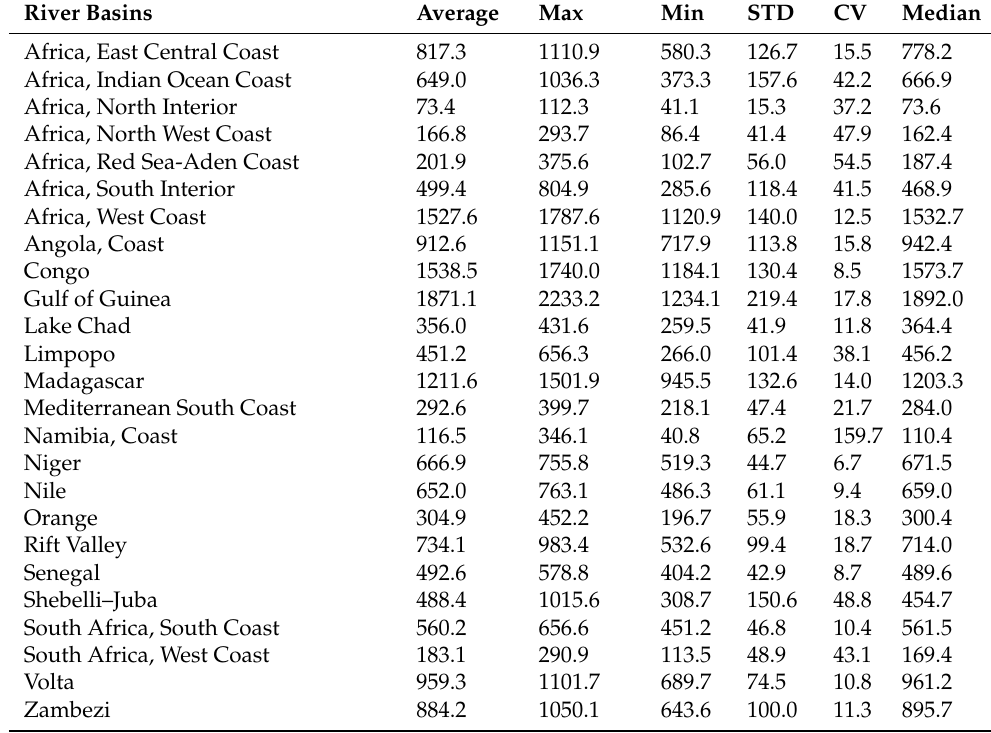
Table 2. Descriptive statistics for Africa’s annual rainfall (in mm) for major river basins from TAMSAT data (1983 to